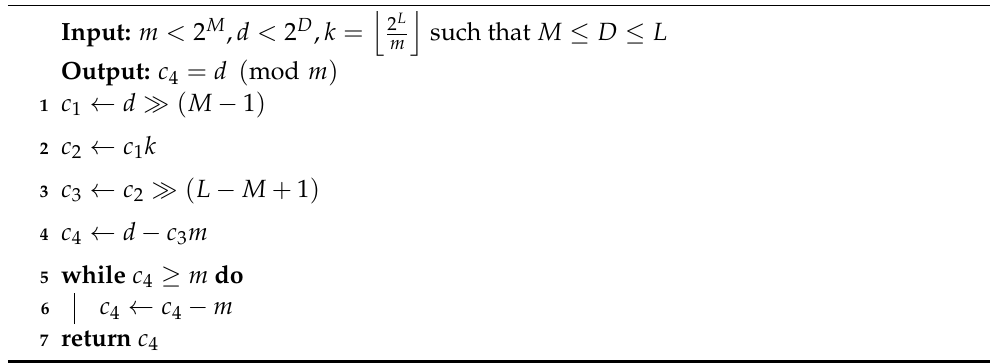
Algorithm 1: Barrett’s algorithm for modular